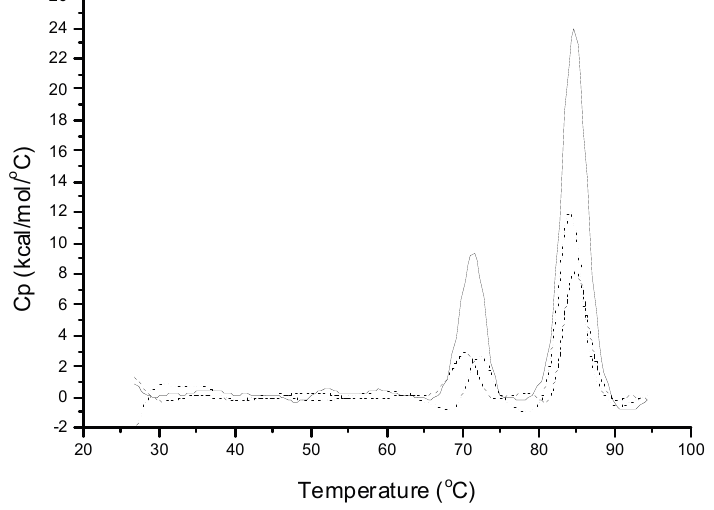
Figure 1. Differential scanning calorimetry (DSC) thermograms of 0.6 mM insulin in phosphate buffer (pH 7.4, 10 mM) and insulin extracted after homogenization. Full line, native insulin solution; dashed line, insulin extracted after homogenization at 5000 rpm; and dotted line, insulin extracted after homogenization at 10,000